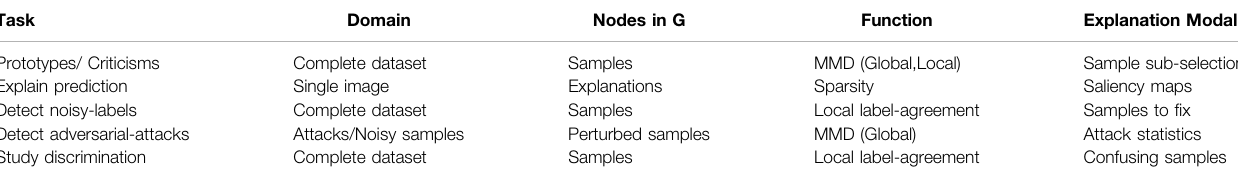
TABLE 1 | Using MARGIN to solve different commonly encountered interpretability